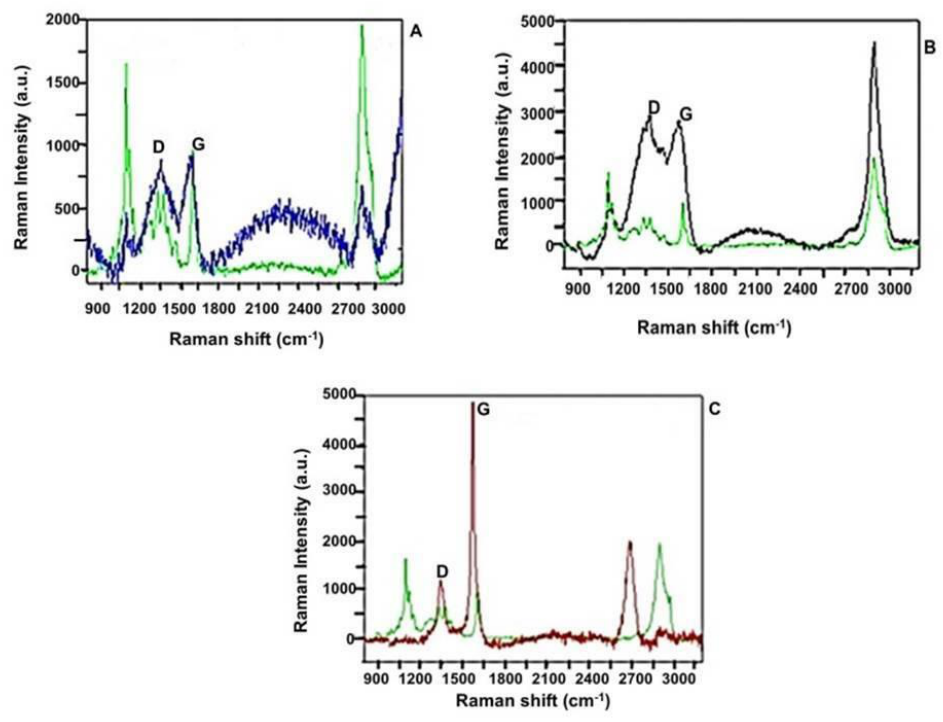
Figure 4. Raman spectroscopy of textiles treated with different concentrations of GO: spectra collected on GO 1% ( A , blue curve), GO 5% ( B , black curve), GO 10% ( C , red curve). Each spectrum is compared with that corresponding to the background signal of the cotton fibers (green